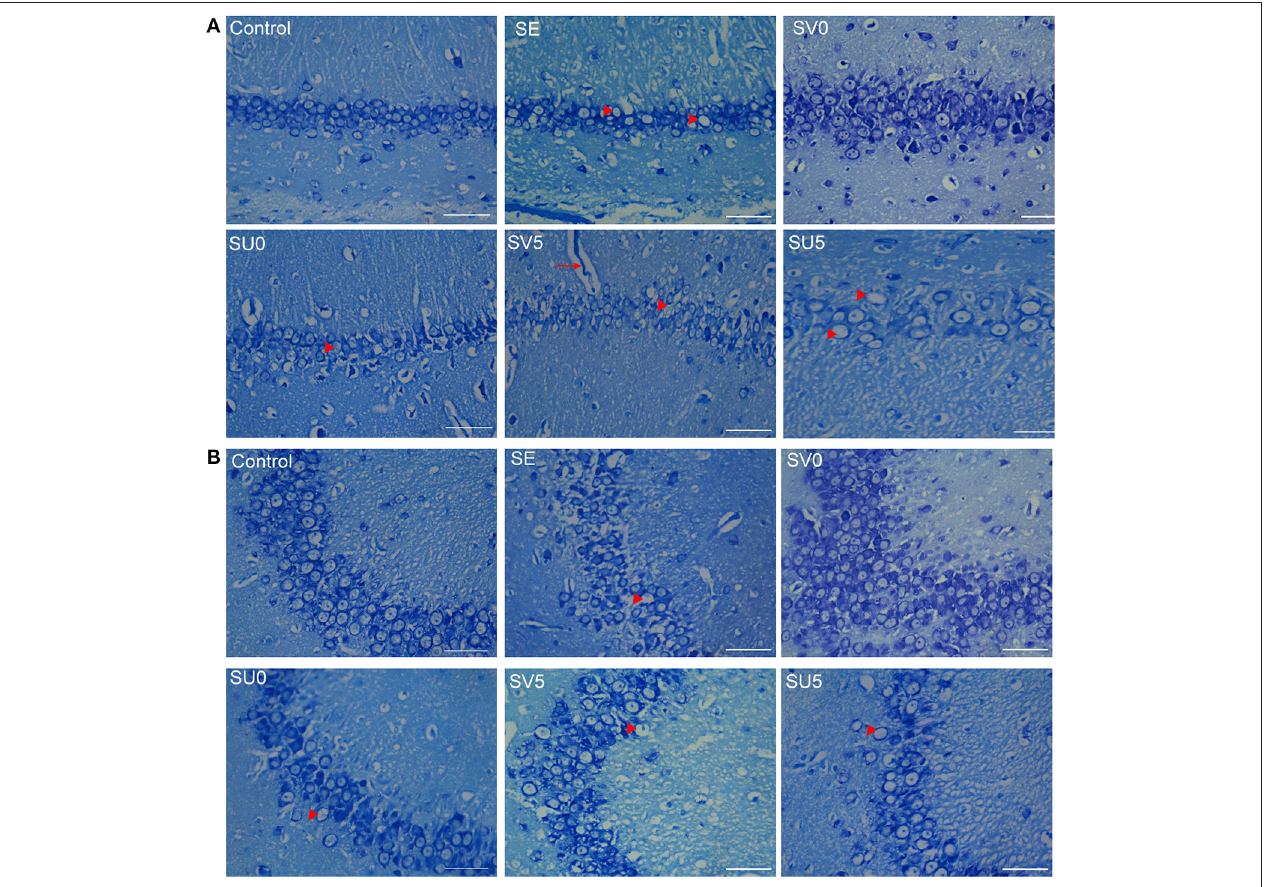
FIGURE 6 | Morphological structure of the hippocampus in different groups in the chronic phase after SE. (A) Morphological structure of the hippocampal CA1 region and (B) CA3 region in the different groups in the chronic phase after SE. Vascular infiltration was observed in the CA1 region in the SV5 group, as shown by arrows (scale bar: 50 µ